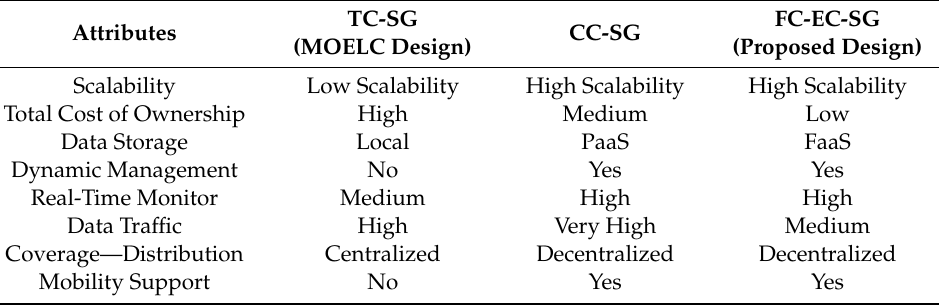
Table 4. Summary of attributes of proposed FC-EC-SG over CC-SG and